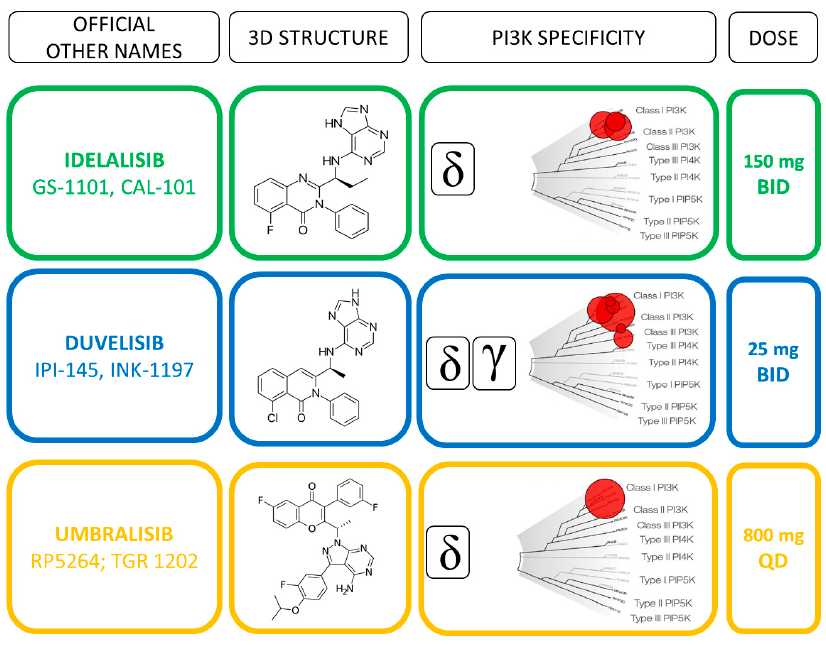
Figure 2 . Direct comparison of idelalisib, duvelisib and umbralisib